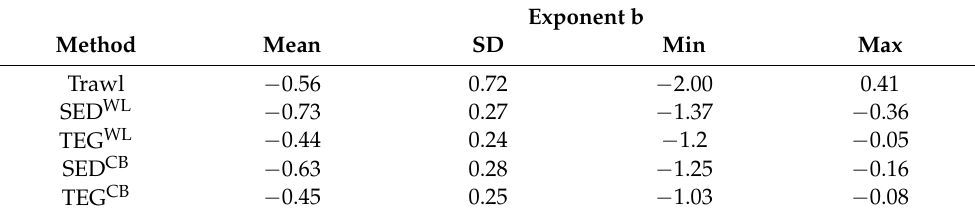
Table 3. Results for size spectra of fish with 1–50 g body weight fitted with maximum likelihood